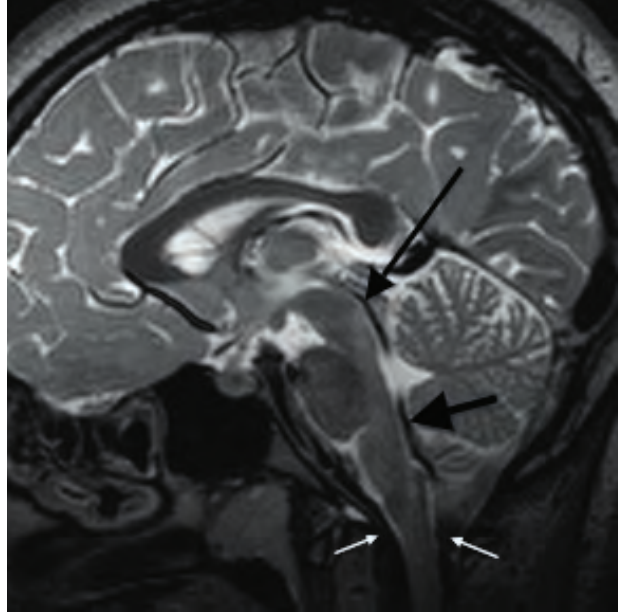
Figs 1(a - e) (structural sagittal MRI imaging of CSF flow) follow